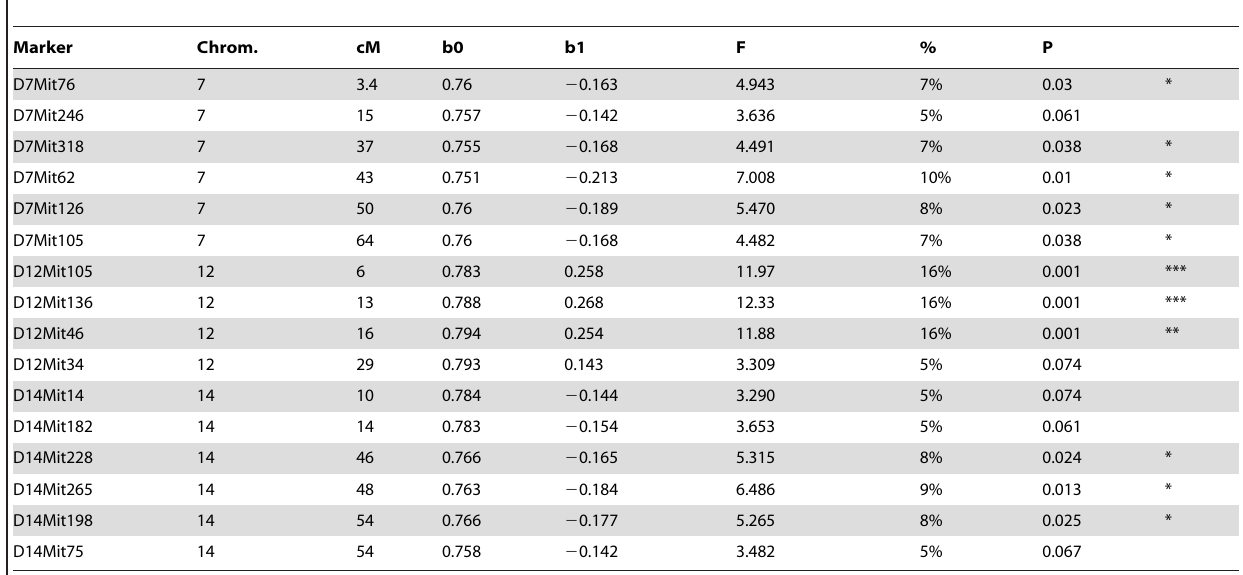
Table 2. Markers showing near-significant and significant association with bFGF-induced corneal neovascularization in a C57BL/ 6J 6 129P3/J F2